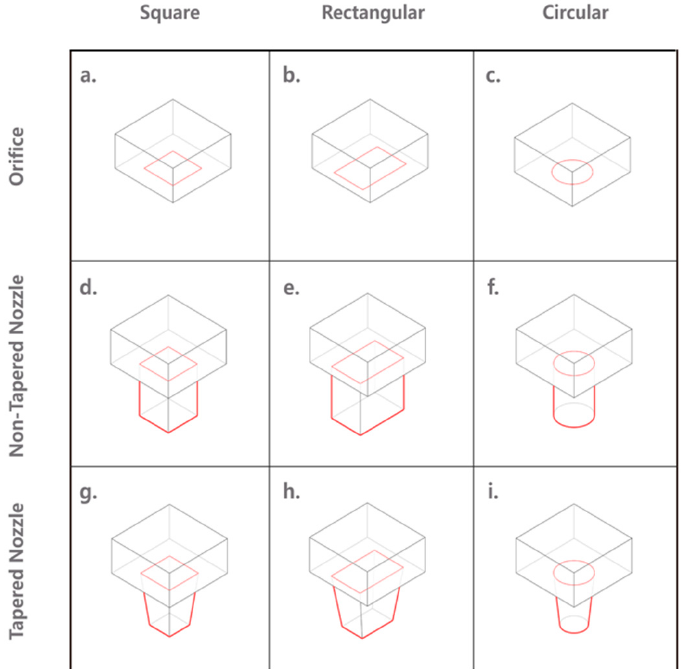
Figure 7. Outlets of different forms (orifice and nozzle), outlet tapering and cross-section shapes: ( a – c ) square, rectangular and circular orifices; ( d – f ) square, rectangular and circular non-tapered nozzles; and ( g – i ) square, rectangular and circular tapered nozzles.